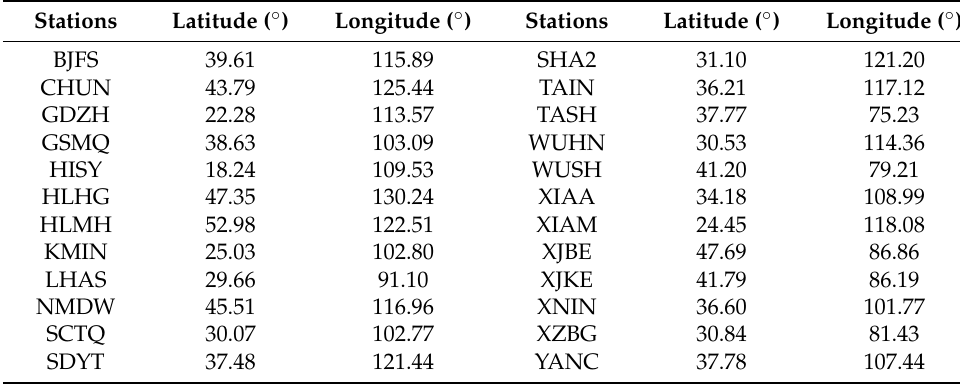
Figure 1. Locations of the 24 GNSS stations from the CMONOC. Table 1. Geographic coordinates of 24 GNSS stations from the CMONOC.